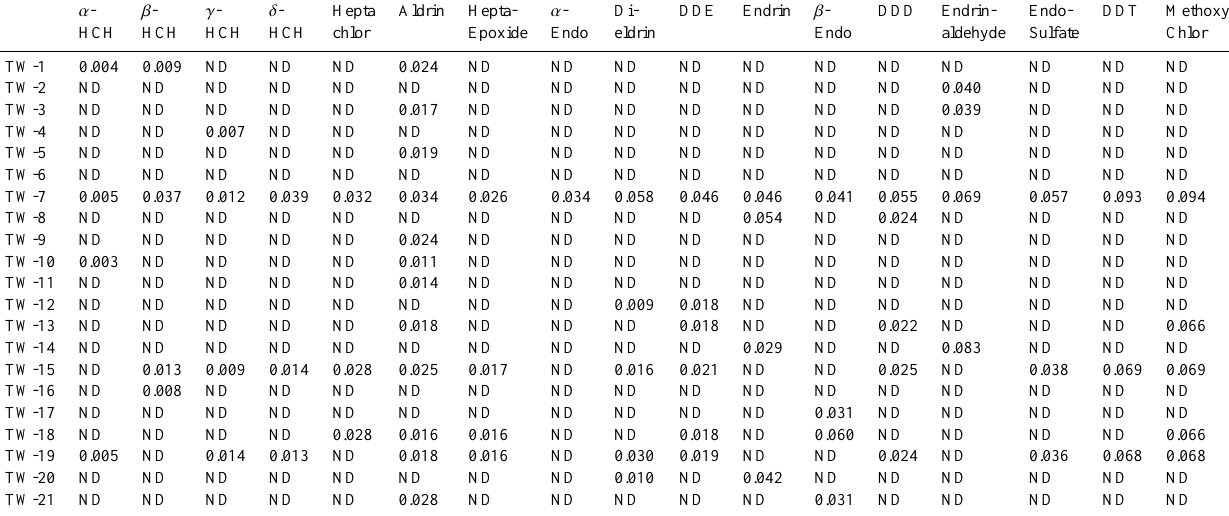
Table 7. Organochlorine residues ( µ gl − 1 ) in ground water (bore well) of Palla area during post-monsoon season. α - β - γ - δ - Hepta Aldrin Hepta- α - Di- DDE Endrin β - DDD Endrin- Endo- DDT Methoxy HCH HCH HCH HCH chlor Epoxide Endo eldrin Endo aldehyde Sulfate Chlor TW-1 0.004 0.009 ND ND ND 0.024 ND ND ND ND ND ND 0.019 ND ND ND ND ND ND ND ND ND ND ND ND ND ND ND ND ND TW-7 0.005 0.037 0.012 0.039 0.032 0.034 0.026 0.034 0.058 0.046 0.046 0.041 0.055 0.069 0.057 0.093 0.094 TW-8 ND ND ND ND ND ND ND ND ND ND 0.054 ND 0.024 ND ND ND ND TW-9 ND ND ND ND ND 0.024 ND ND ND ND ND ND ND ND ND ND ND TW-10 0.003 ND ND ND ND 0.011 ND ND